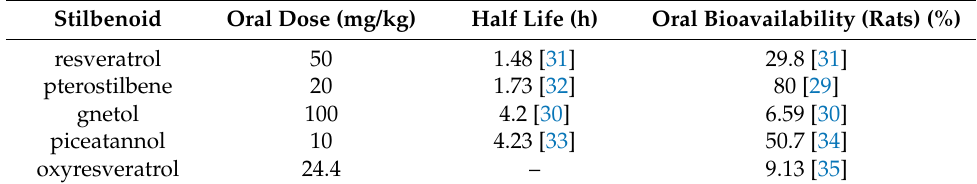
Table 1. Half-lives and oral bioavailabilities of stilbenoids after oral administration in